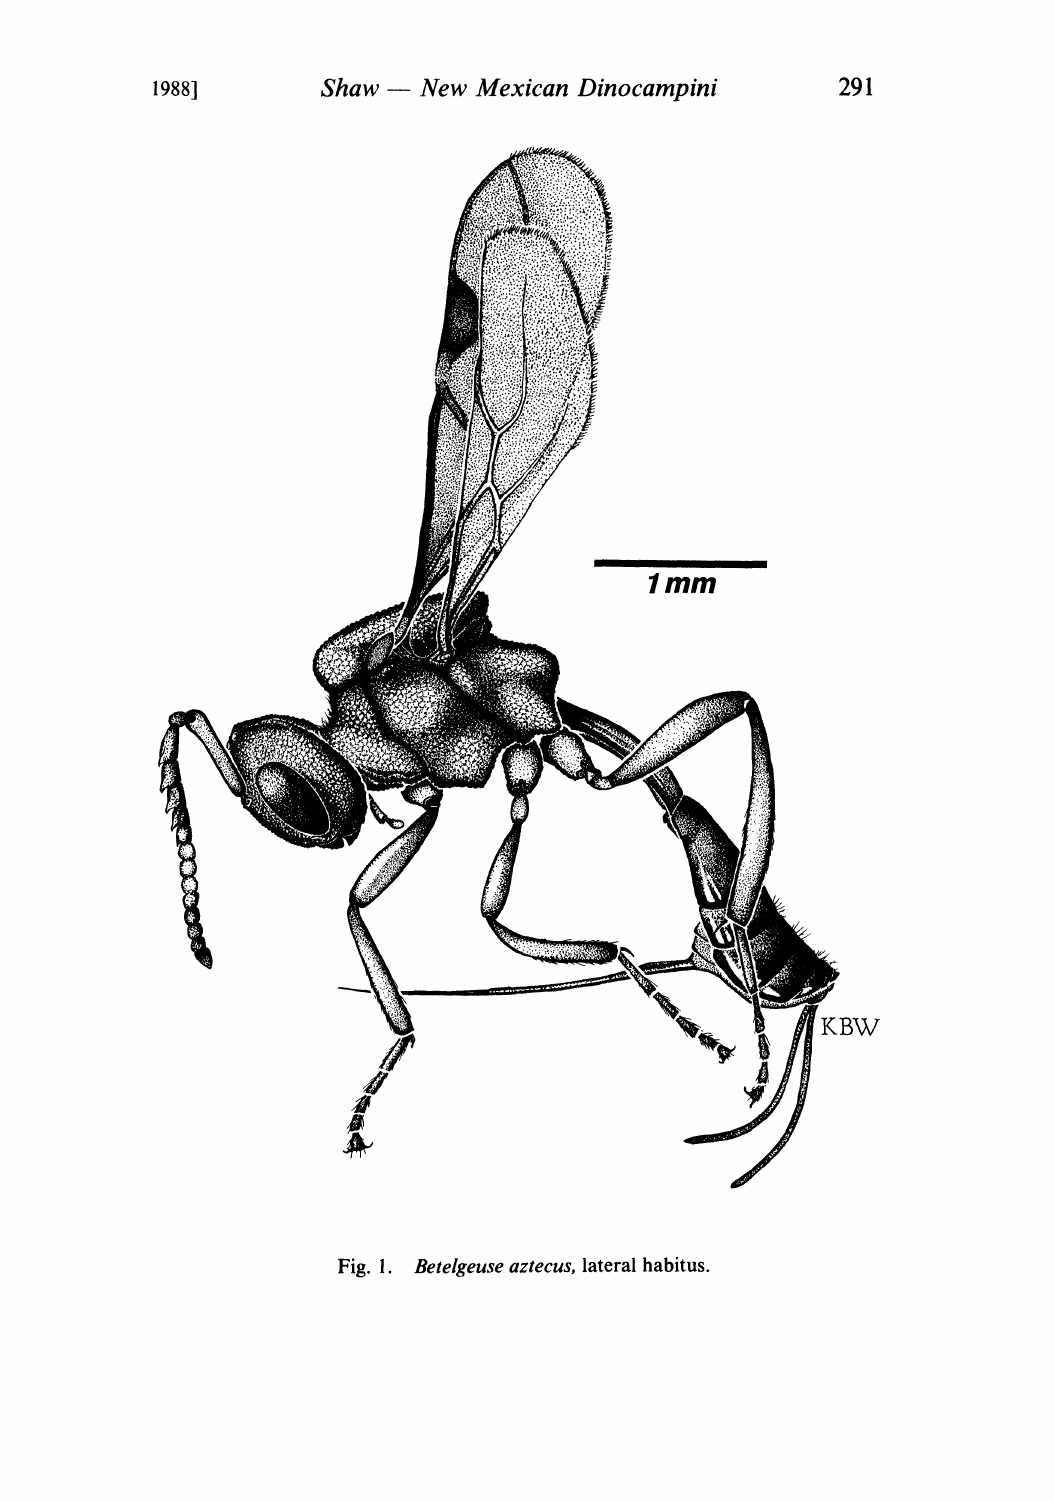
Fig. 1. Betelgeuse aztecus, lateral